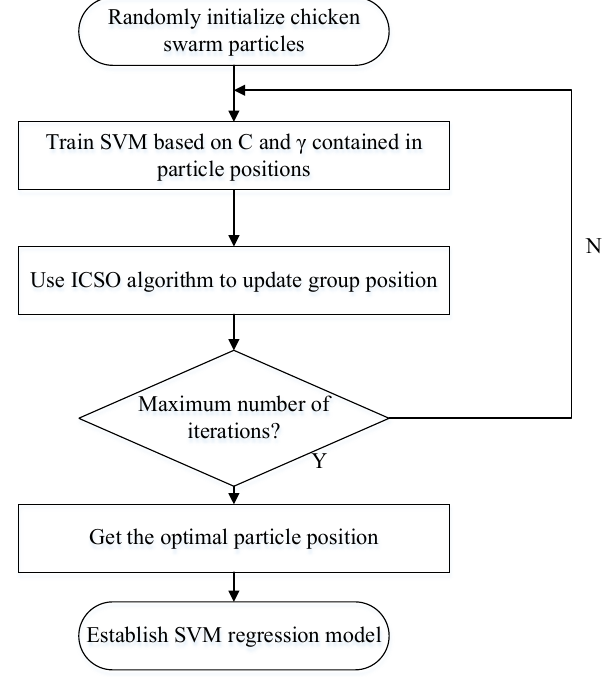
Figure 1. Flow chart of ICSO algorithm optimizing SVM parameters.